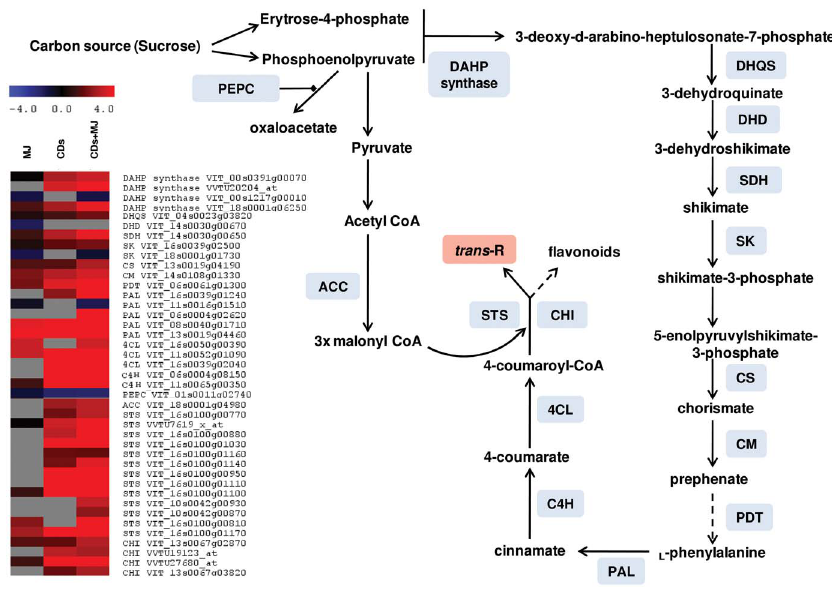
Figure 5. Modulation of trans -resveratrol biosynthesis pathway encoding enzymes gene expression by CD (cyclodextrins) and/or MJ (methyl jasmonate). Enzyme abbreviations: 4CL, 4-coumarate CoA ligase; ACC, acetyl-CoA carboxylase; C4H, cinnamate-4-hydroxylase; CHI, chalcone isomerase; CM, chorismate mutase; CS, chorismate synthase; DAHP synthase, 3-deoxy-D-arabino-heptulosonate 7-phosphate synthase; DHD, dehydroquinate dehydratase; DHQS, 3-dehydroquinate synthase; PAL, phenylalanine ammonia lyase; PDT, prephenate dehydratase; PEPC, phosphoenolpyruvate carboxylase; SDH, shikimate dehydrogenase; SK, shikimate kinase; STS, stilbene synthase.